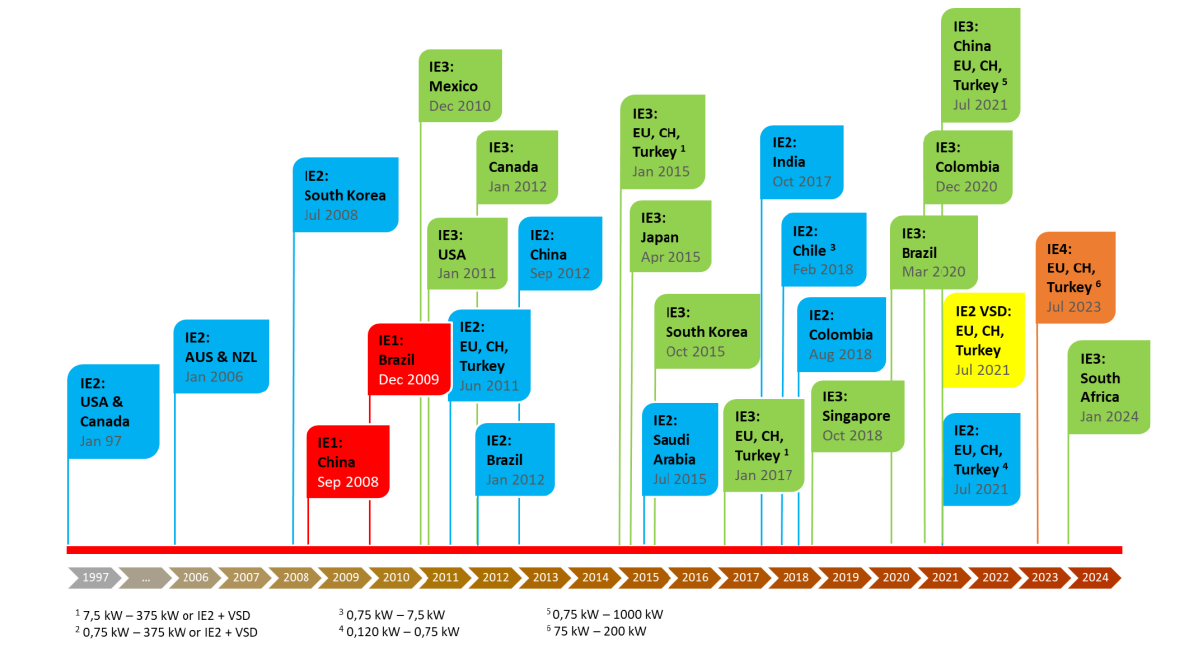
Figure 3. Timeline of introduction of MEPS in different countries/economies (Source: Authors).